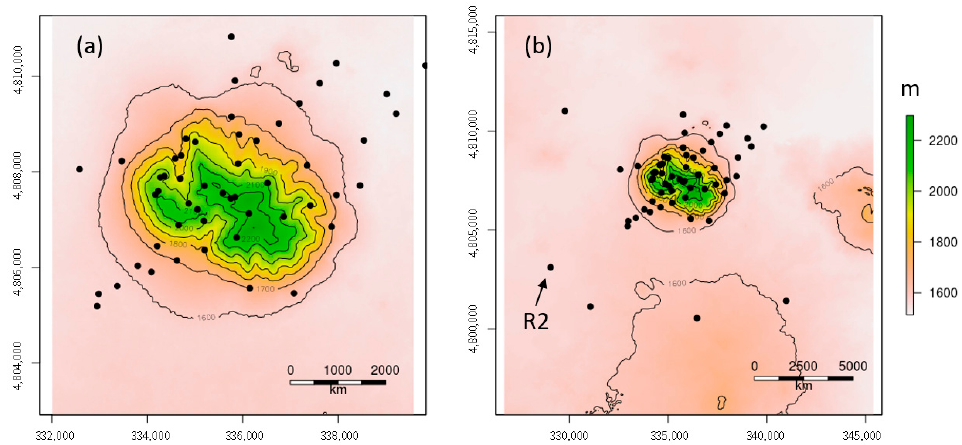
Figure 5. Big Southern Butte terrain and measurement locations. Panel ( a ) is zoomed in on the butte and ( b ) shows the full study area and the location of reference sensor R2. Axes labels are in meters and north is toward the top of the figure.